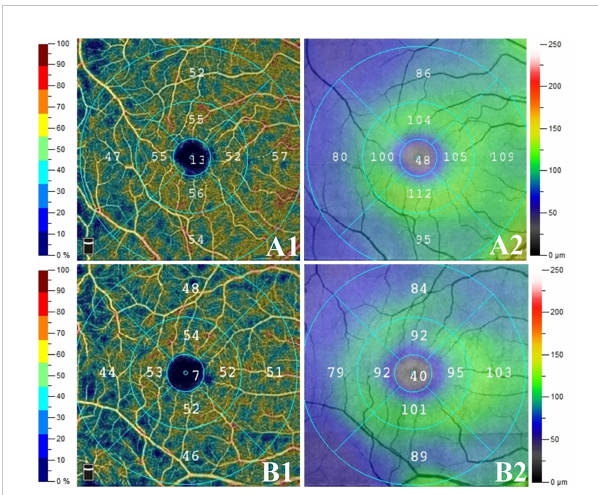
FIGURE 1 Representative images of the vessel density and GCC thickness in two groups. The right eyes of two age-matched male patients with preclinical diabetic retinopathy: (A) non- diabetic nephropathy (NDN) group, (B) DN group; (1) super fi cial capillary plexus (SCP) vessel density, (2) ganglion cell complex (GCC) thicknesses. Compared to NDN group, SCP vessel density and GCC thicknesses reduced in DN group. Moreover, more dark blue area was noticed in DN group than in NDN group.